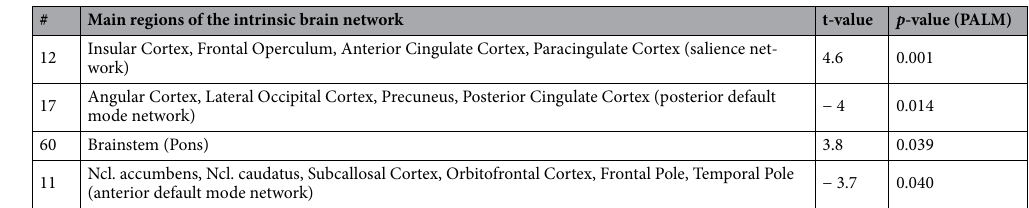
Table 1. Intrinsic brain networks that encode the intensity of CBP. The t-values represent the relationship between the fluctuating subjective experience of CBP and the time course of component activity (see Fig. 1,